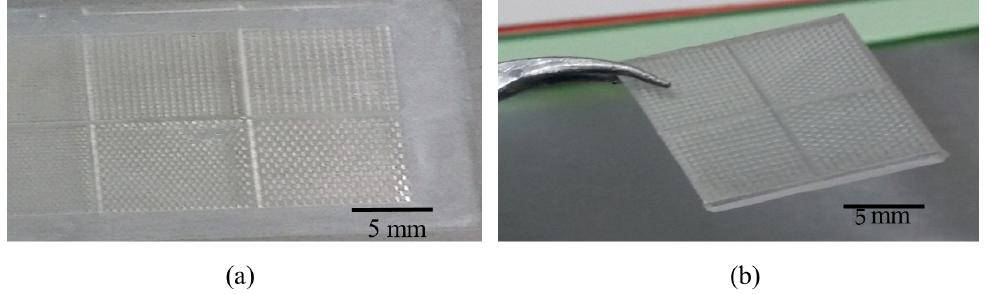
Figure 5. ( a ) Image of array of SU8 mold and ( b ) image of PDMS